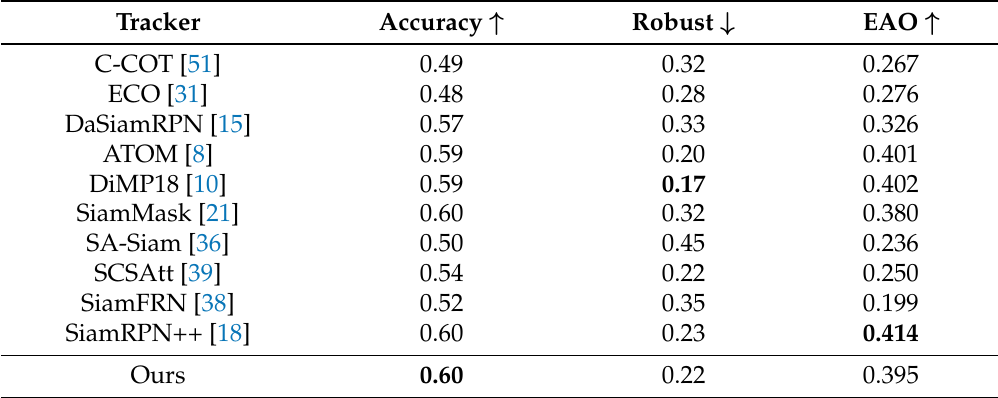
Table 2. Experimental results of our algorithm with other algorithms on the VOT2018 dataset. The bolded values in the table are the best performance.